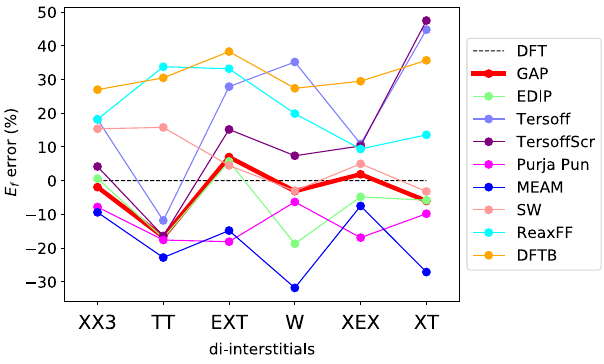
FIG. 26. Percentage error in the formation energy of di- interstitials ( I 2 ) in various configurations for a variety of interatomic potentials, relative to the